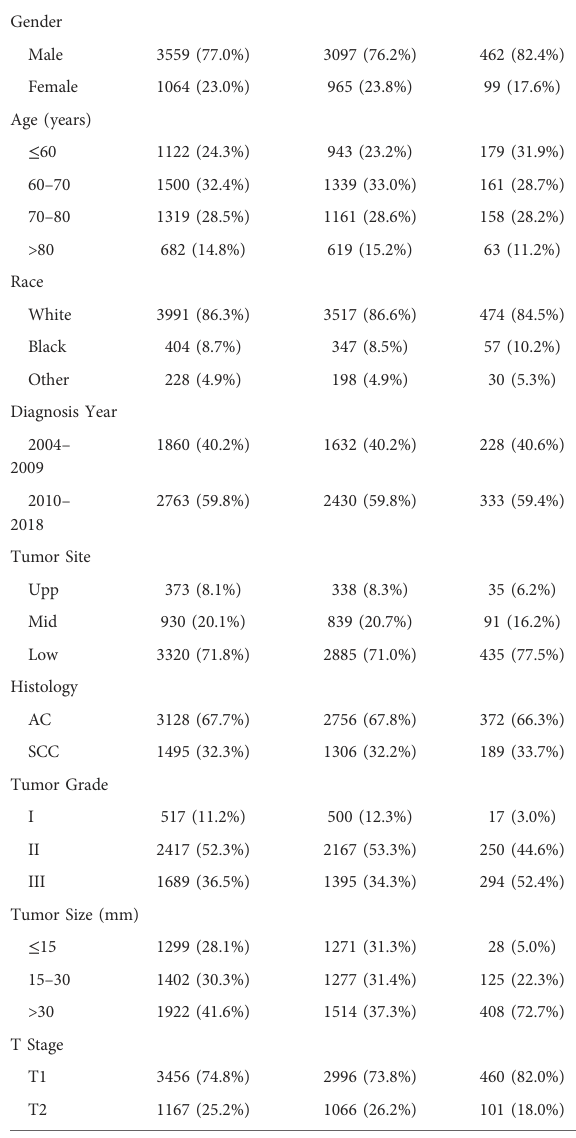
TABLE 1 Clinicopathological variables of patients with T1-2N0 esophageal cancer.